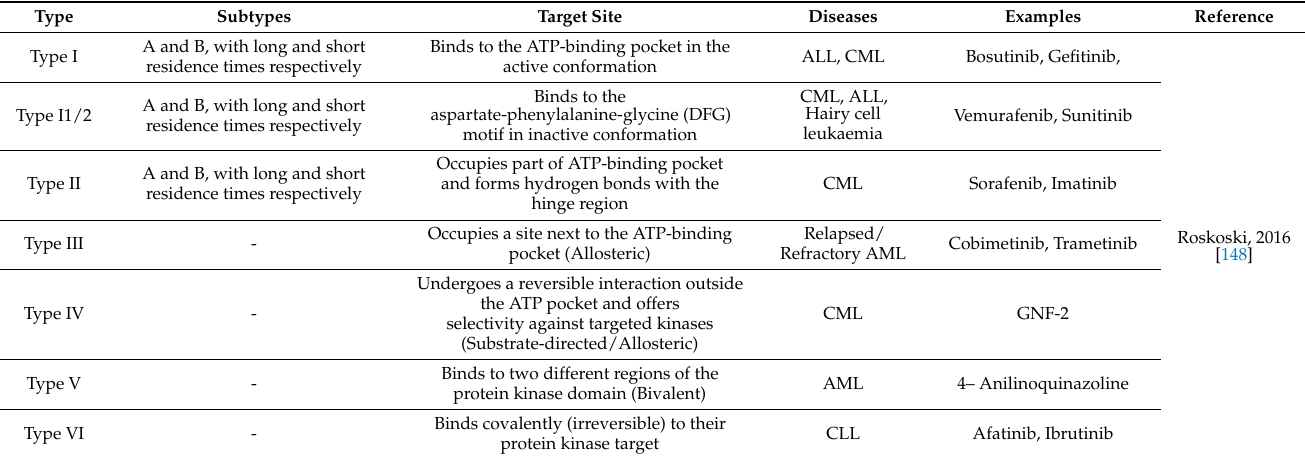
Table 3. Classification of protein kinase